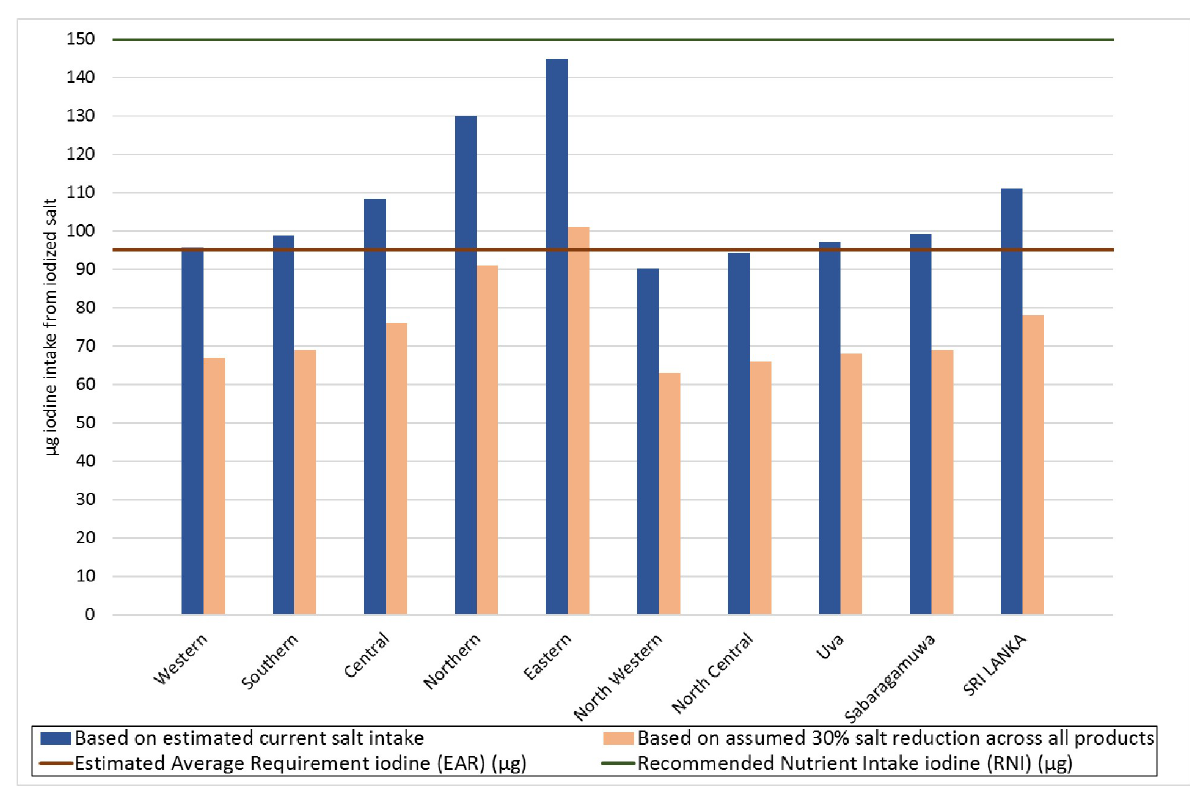
Fig 2. Potential impact of successful 30% salt reduction on iodine intake from household salt and salt in selected IPF in relation to iodine intake reference values by provinces. [Tolerable Upper Limit for iodine intake = 600 μ g not shown].